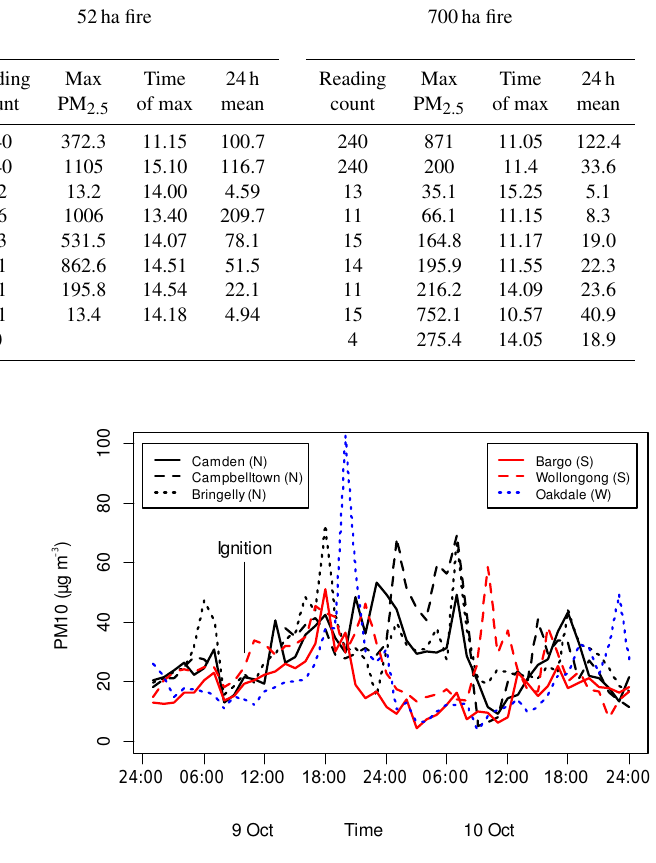
Figure 6. Trace of PM 10 measurements for the 700ha from the Office of Environment and Heritage permanent air quality